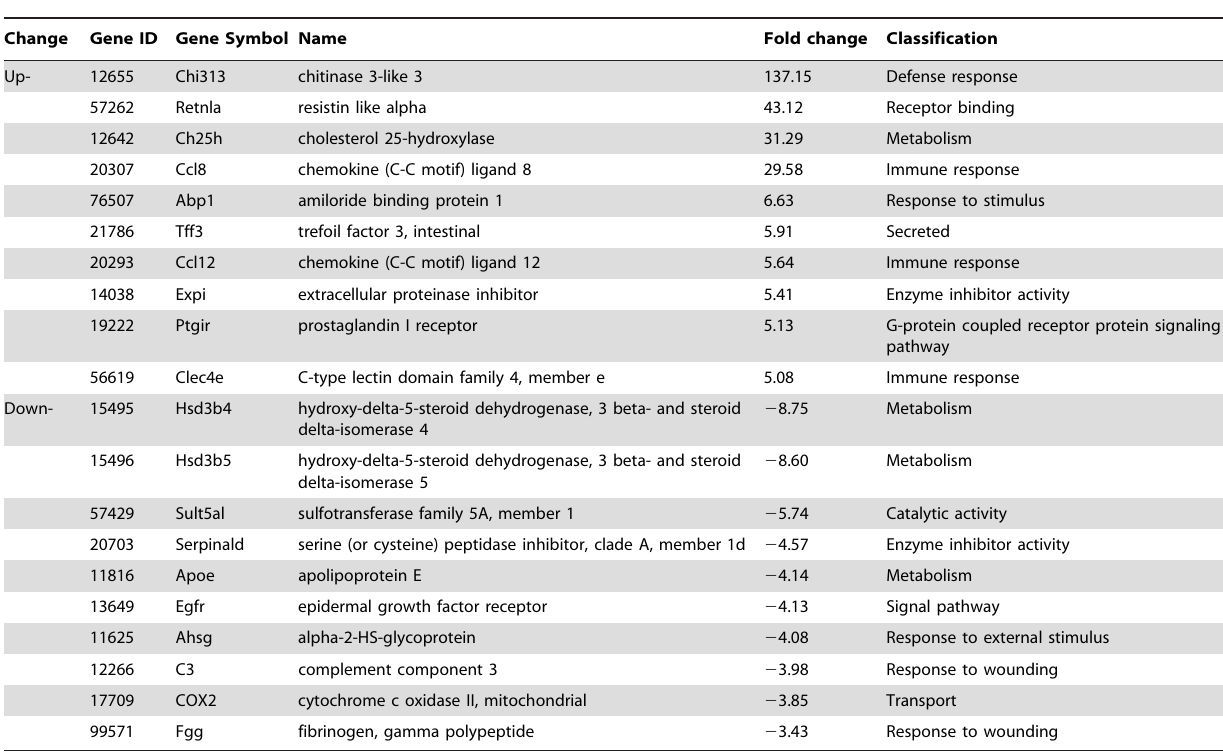
Table 1. Top 10 up- or down-regulated differentially expressed genes and their GO clustering classification at 1 month after intrahepatic injection of E. multilocularis metacestode (infected mice), compared to intrahepatic injection of saline (non-infected